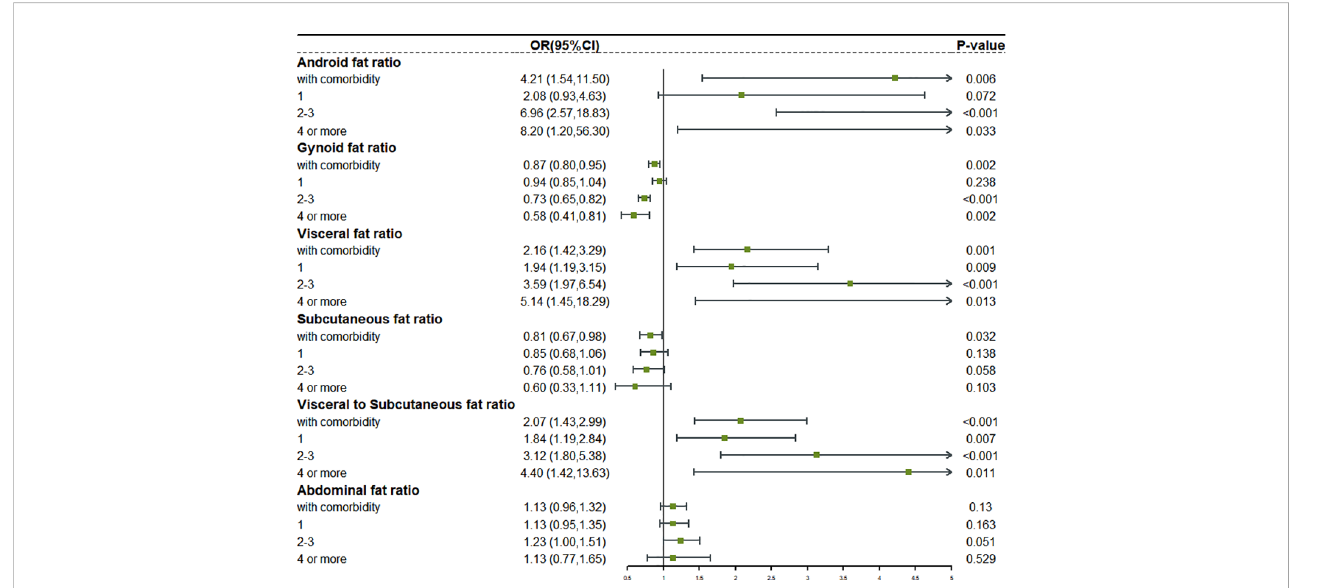
FIGURE 3 The relationship between different fat distribution and different degrees of comorbidity in obese